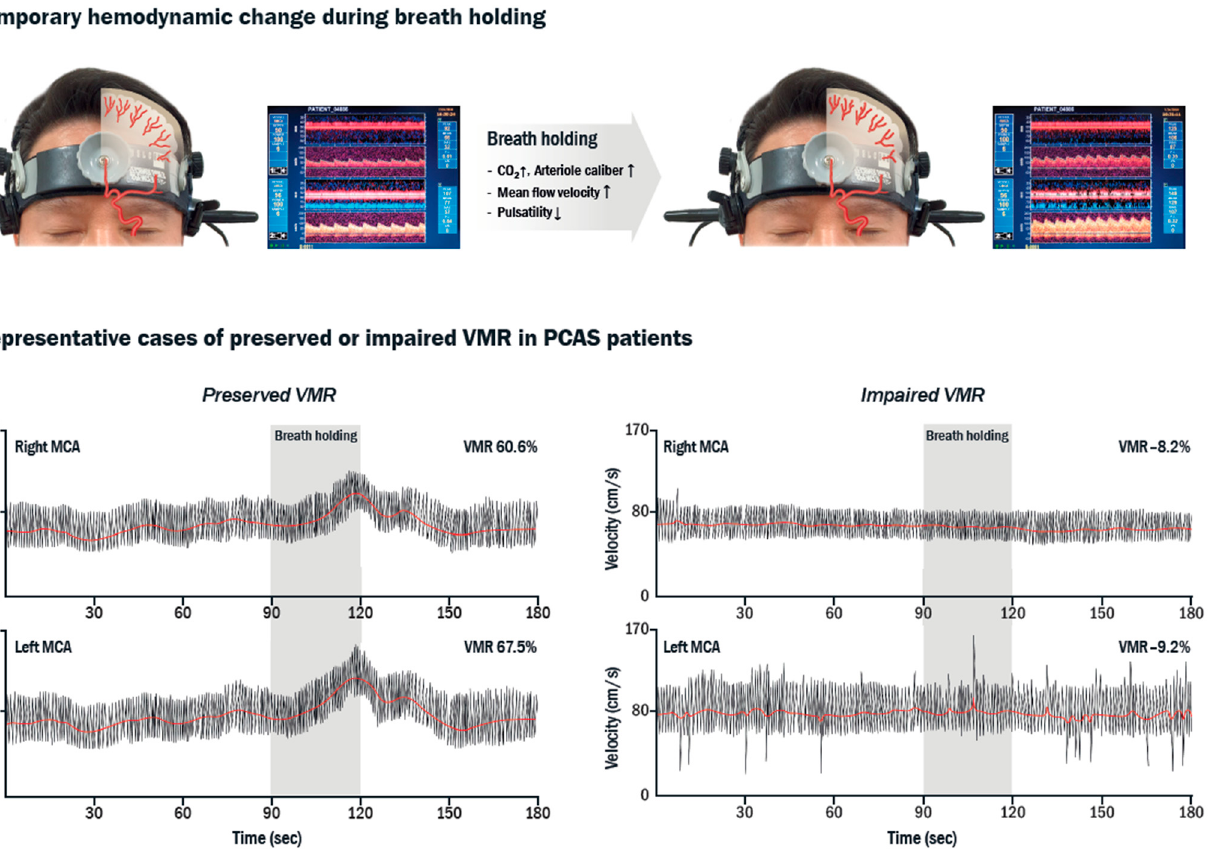
Figure 2. Methods of vasomotor reactivity test using transcranial Doppler (TCD-VMR). ( A ) Temporary hemodynamic change during TCD-VMR test by breath-holding maneuver. ( B ) Representative cases of preserved or impaired vasomotor reactivity in patients with post-cardiac arrest syndrome.